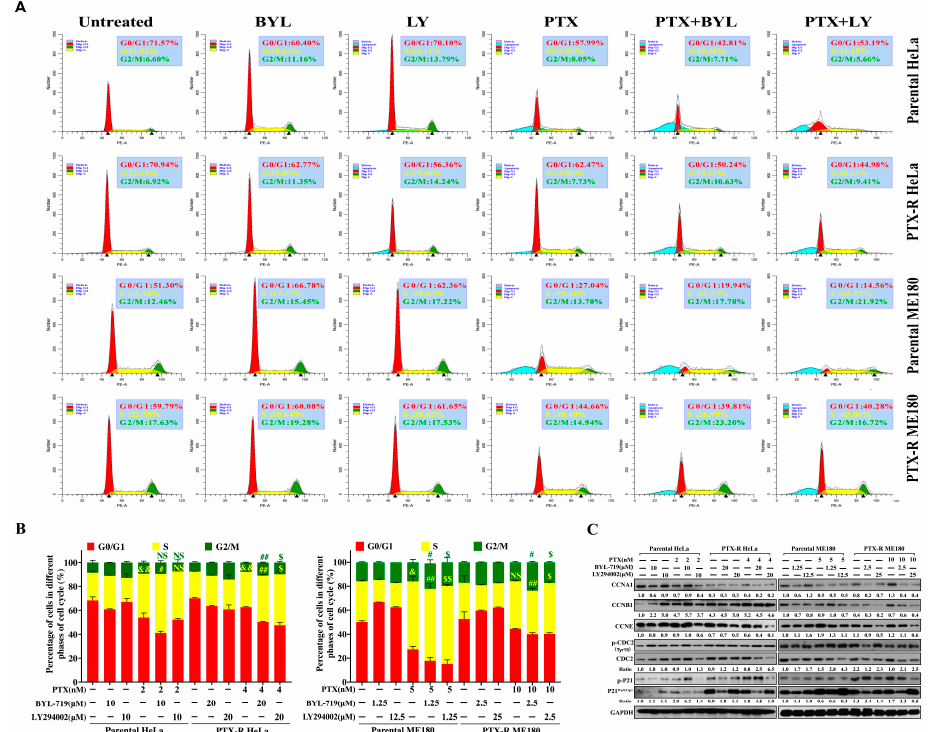
Figure 4. The combination BYL-719 or LY294002 with a low dose of paclitaxel arrests the cell-cycle in S-G 2 M phases in parental and paclitaxel-resistant HeLa and ME180 cells following 48 h treatment. The representative images ( A ) and column graphs ( B ) show that BYL-719 or LY294002 significantly enhanced low-dose paclitaxel–induced S phase arrest in both parental and paclitaxel-resistant HeLa and ME180 cells. Statistical evaluations were performed using Tukey’s one-way ANOVA to obtain significant di ff erences, with normalization based on the untreated group. “&” and “&&” represent p < 0.05 and p < 0.01, untreated versus paclitaxel in S and G 2 M phase, respectively. “#” and “##” represent p < 0.05 and p < 0.01, paclitaxel vs. paclitaxel + BYL-719, in S and G 2 M phases, respectively. “$” and “$$” represent p < 0.05 and p < 0.01, paclitaxel vs. paclitaxel + LY294002, in S and G 2 M phases, respectively. Red, yellow, green, and blue indicate G 0 / G 1 , S, G 2 M, and sub-G 1 phases (apoptotic cells), respectively. ( C ) The representative western blots (the mean value is presented below the bands from three independent experiments) showing that a combination of BYL-719 or LY294002 with a low dose of paclitaxel caused a significant reduction in cyclin A1, cyclin B1, and cyclin E levels, and induced p-Cdc2 / Cdc2 expression. The phosphorylation of p21 in combination-treated groups was enhanced for BYL-719 and paclitaxel, while it was restored for LY294002 and paclitaxel compared to each drug alone. The quantification of bands was performed by densitometric analysis. The ratio values in a western blot (WB) panel represent the ratio of phosphorylated and total proteins, while others are compared with GAPDH.